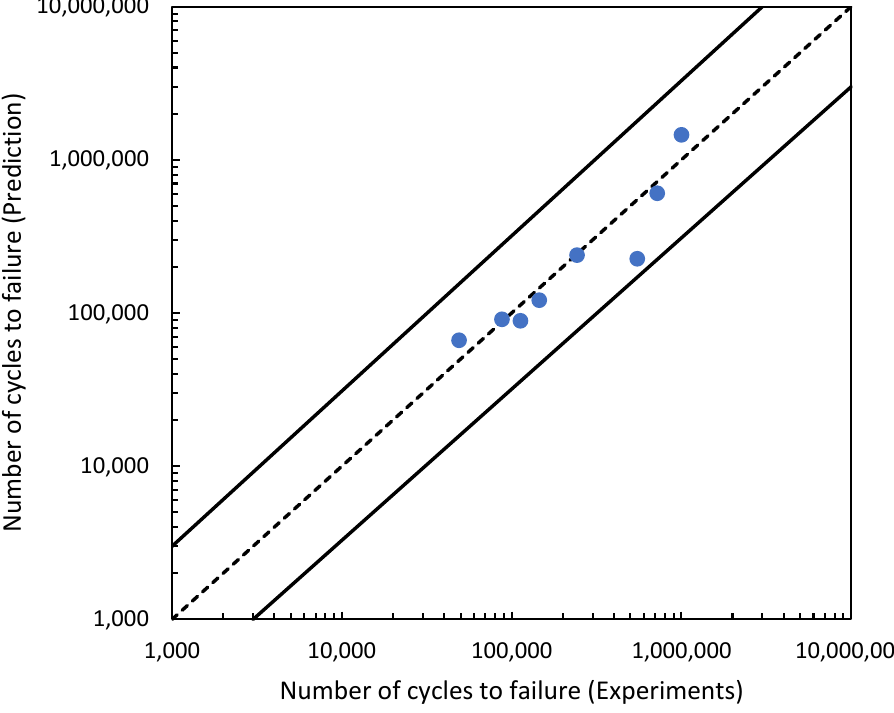
Figure 17. Correlation curve for the modified fatigue life model of the Basquin equation and experi- ments fatigue life.